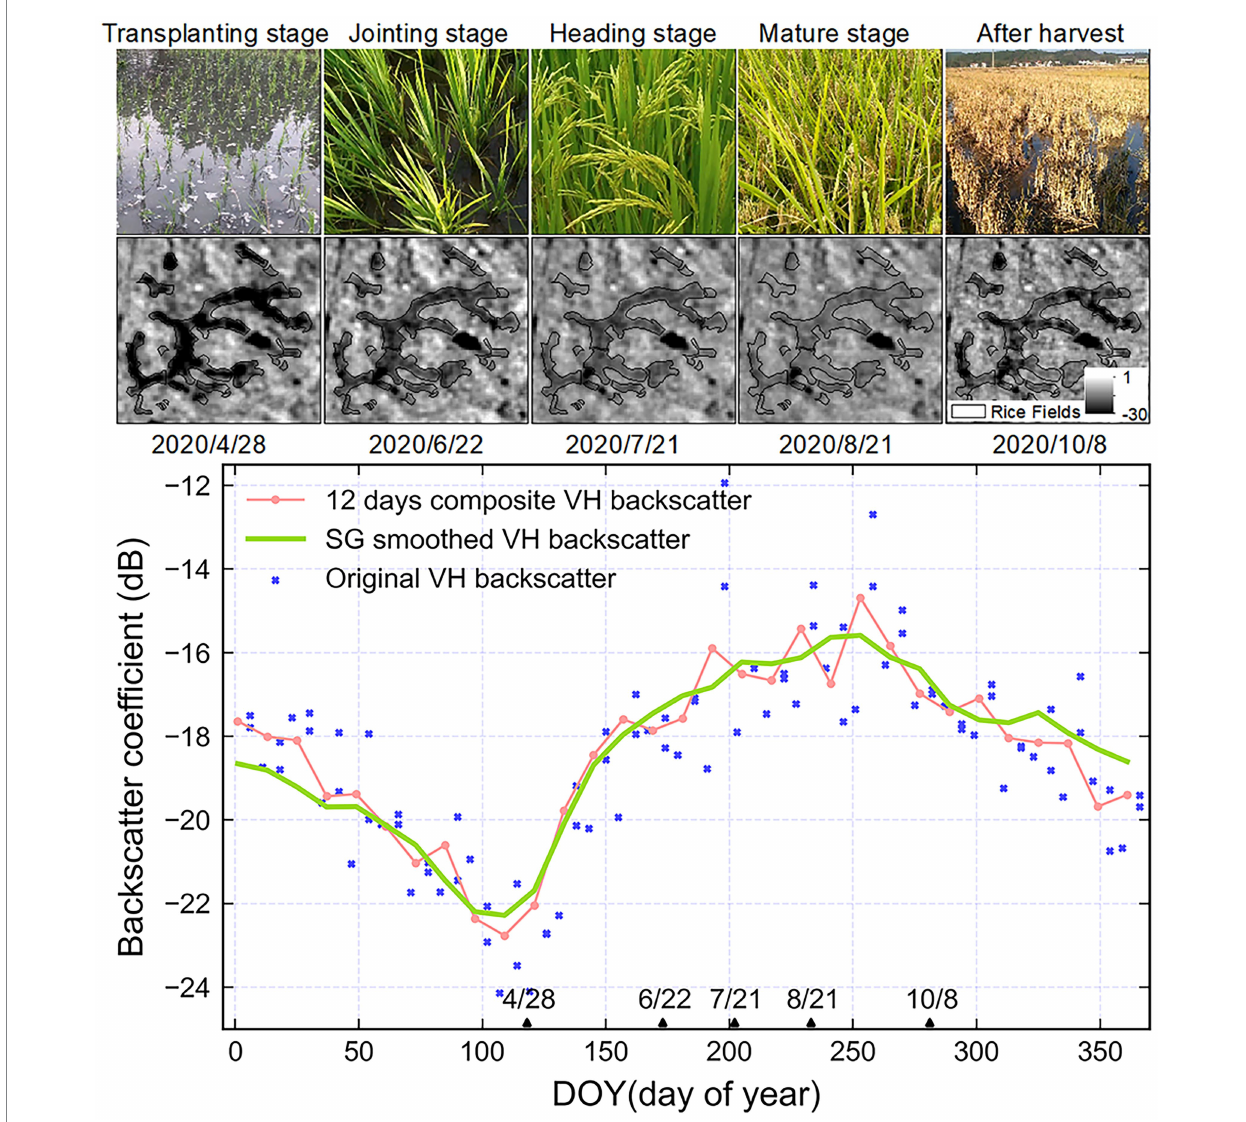
FIGURE 3 Rice fields status at key phenological stages and reconstruction of the sentinel-1 SAR time-series backscatter